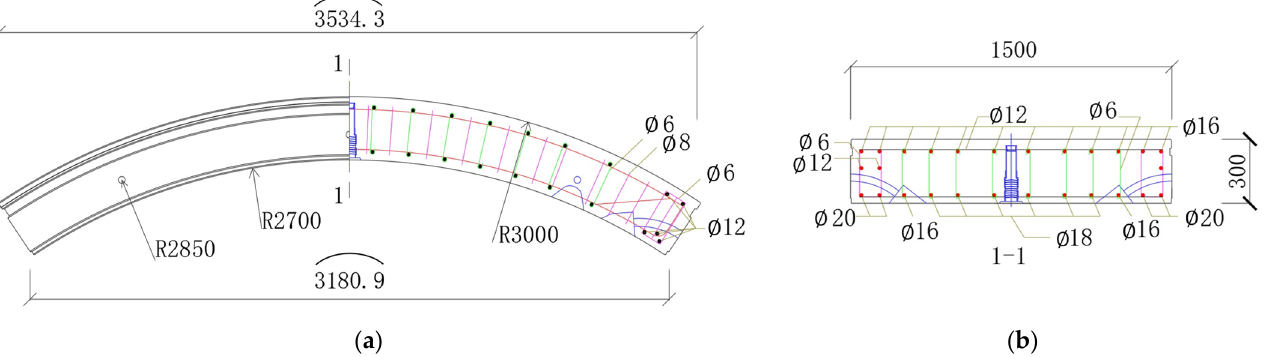
Figure 10. ( a ) The layout of segment B2 and ( b ) the sectional view of cross-section 1-1 (unit: mm).